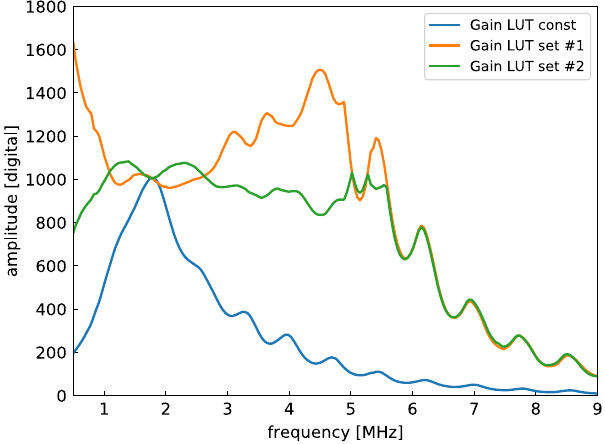
FIG. 17. Comparison of the amplitude responses with the constant gain LUT, the first and second gain LUT